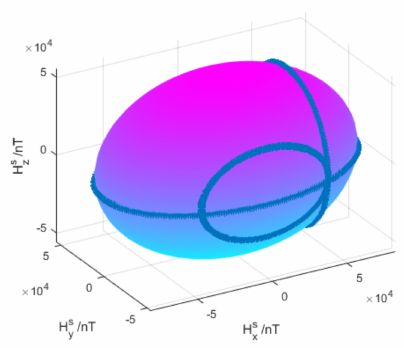
Figure 5. Diagram of ellipsoid fitting.